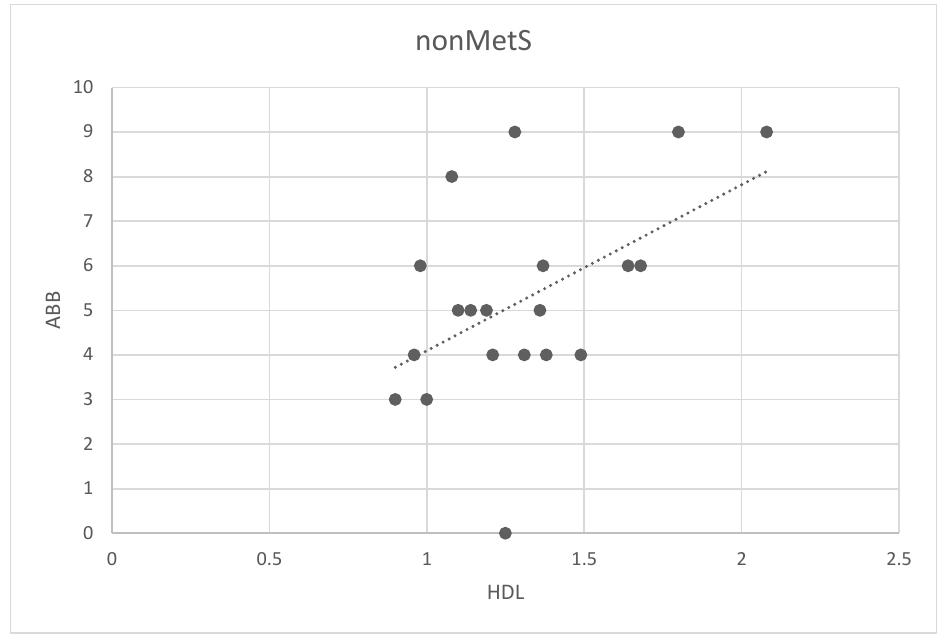
Figure 4. Correlation between the number of ABB and HDL levels in non-MetS patients. Legend: The scatter plot shows the relationship between the number of ABB and HDL levels. Spots represent the plotted values of the measured variables obtained for each patient, and the line represents the best fit for the correlation.